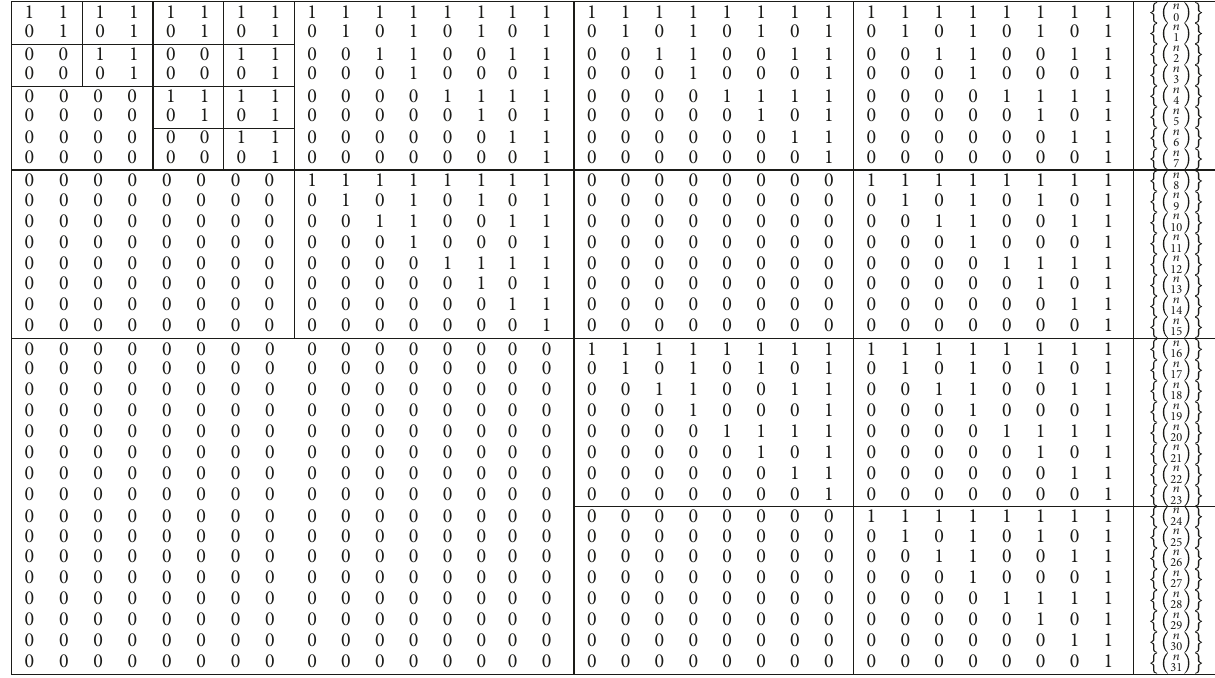
Figure 8: The first 32 binomial sequences.